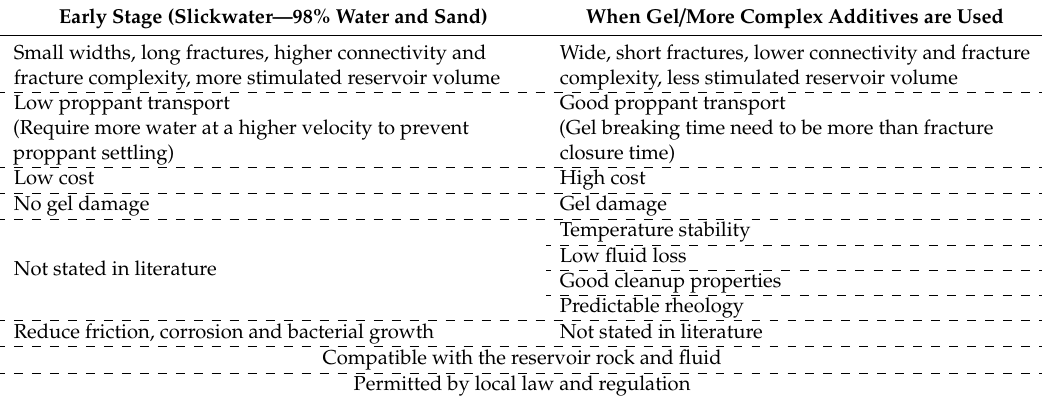
Wide, short fractures, lower connectivity and fracture complexity, less stimulated reservoir volume Good proppant transport (Gel breaking time need to be more than